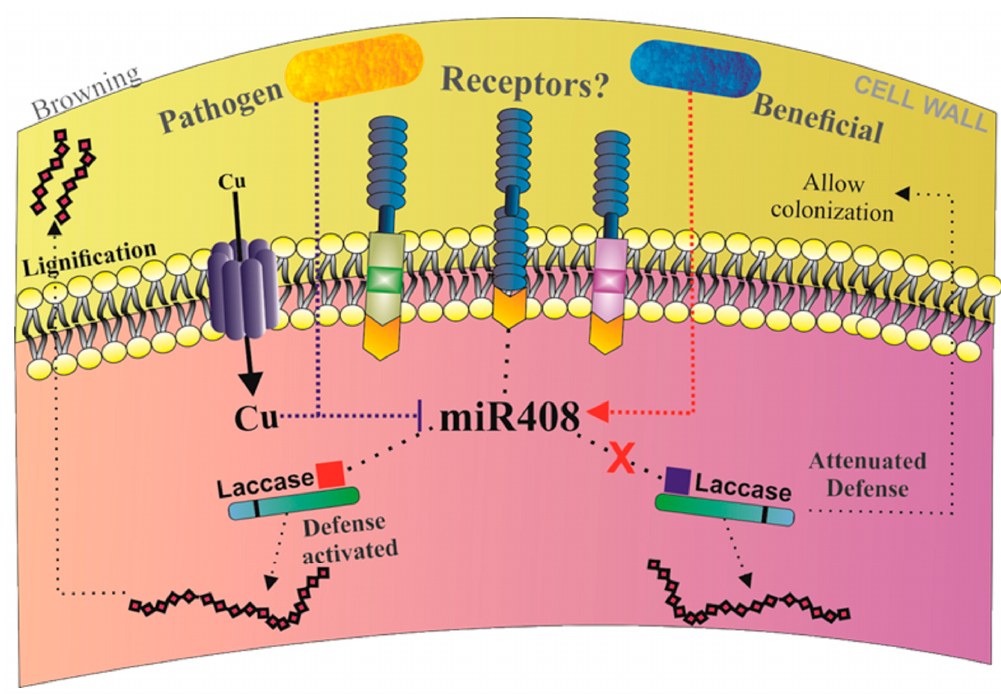
Figure 10. Model of sugarcane miR408 regulation in response to pathogen and beneficial endophytic diazotrophic bacteria. Pathogens attack sugarcane and trigger an upregulation of copper transporter as well as an increase in copper inside the cell resulting in a repression of miR408; consequently, the level of its targets increases. This regulation can result in cell wall lignification and browning. In contrast, the upregulation of miR408 can result in beneficial diazotrophic bacteria colonization by the cleavage of laccase.